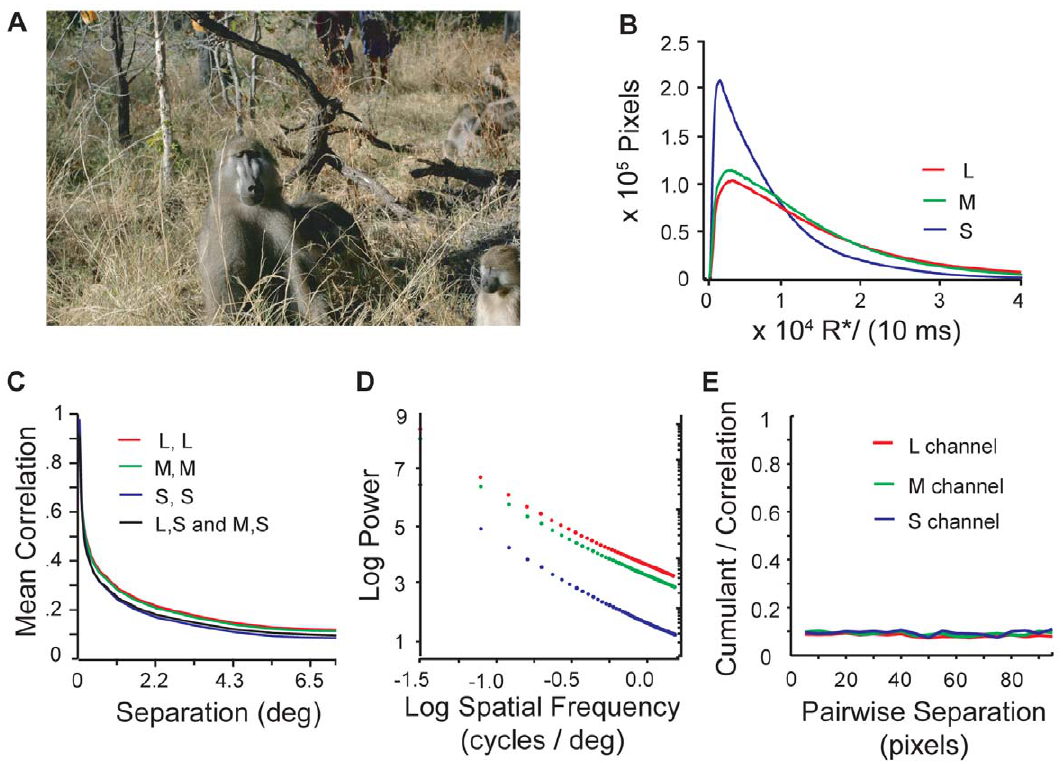
Figure 1. Statistics of cone responses to natural images. A) Image from Okavango Delta, Botswana image database (Photo credit: Lucia Seyfarth). B) Histogram of cone response intensity in units of cone opsin photoisomerizations per cone per 10 ms. S cone signals peak at lower values than L and M cone signals, which are similar. C) Correlation between cone signals declines with spatial separation but remain significantly positive at large separations. Correlations between cone signals from different cone types are nearly as large as the correlations between cone signals from cones of the same type. Cross-correlations between L and S cones and between M and S cones were indistinguishable and are plotted with the same black line. D) The power spectrum in each color channel shows that correlations are approximately scale invariant over several log units of spatial frequency. E) At all spatial scales 90% of the correlations between three equally separated points in an image arise from underlying pairwise correlations (see